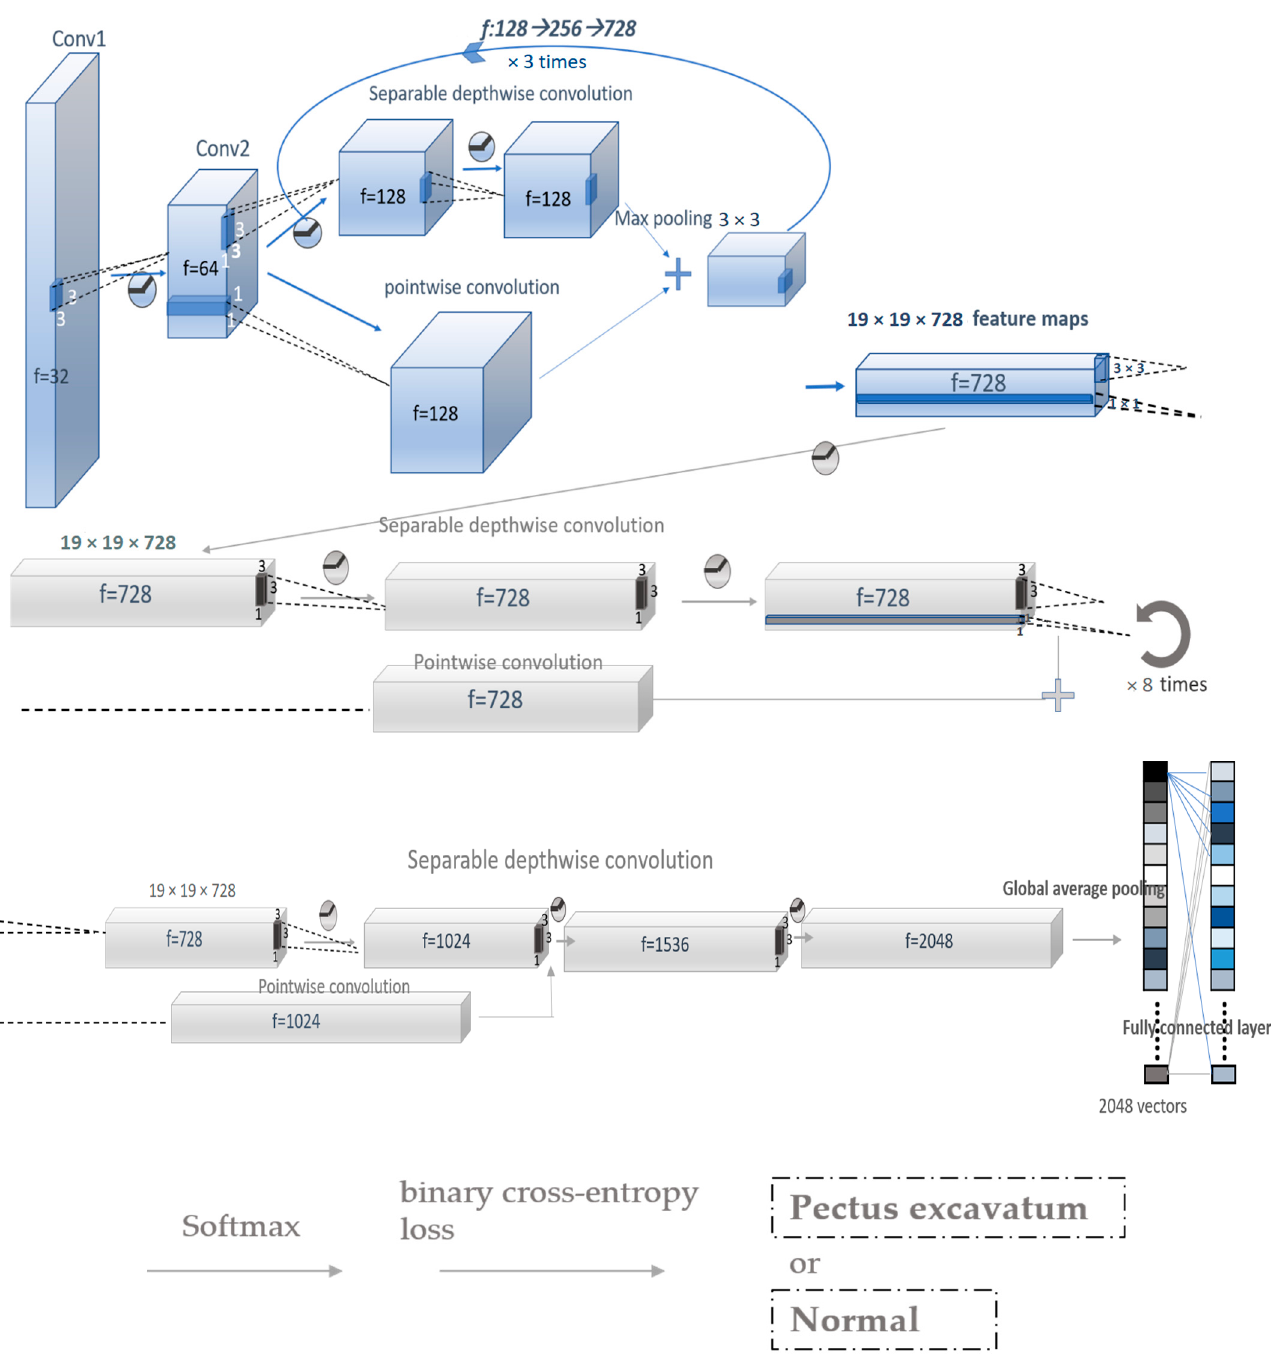
Figure 3. Xception architecture diagram: Xception is a complex multiple layers (deep) CNN structure which contains both separatable depth-wise and pointwise convolutional layers. The Xception architecture is composed of entry flow, middle flow and exit flow. After going through the entry flow (blue part), the data then go through the middle flow which is repeated eight times (middle grey part), and finally through the exit flow. After fully connected layer, all vectors go through SoftMax function then binary cross-entropy loss to obtain binary classification